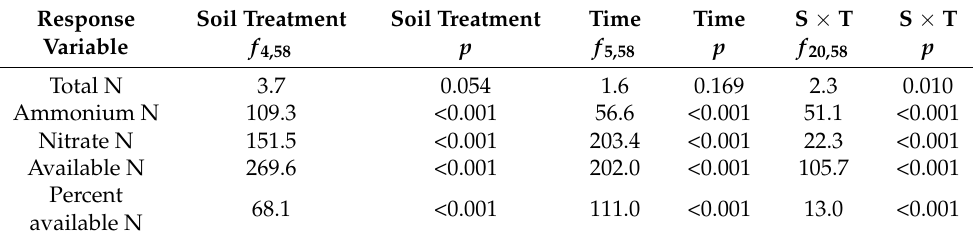
Table 2. Results from 5 soil treatment × 6 incubation time factorial ANOVA for soil nitrogen (N) variables. n =